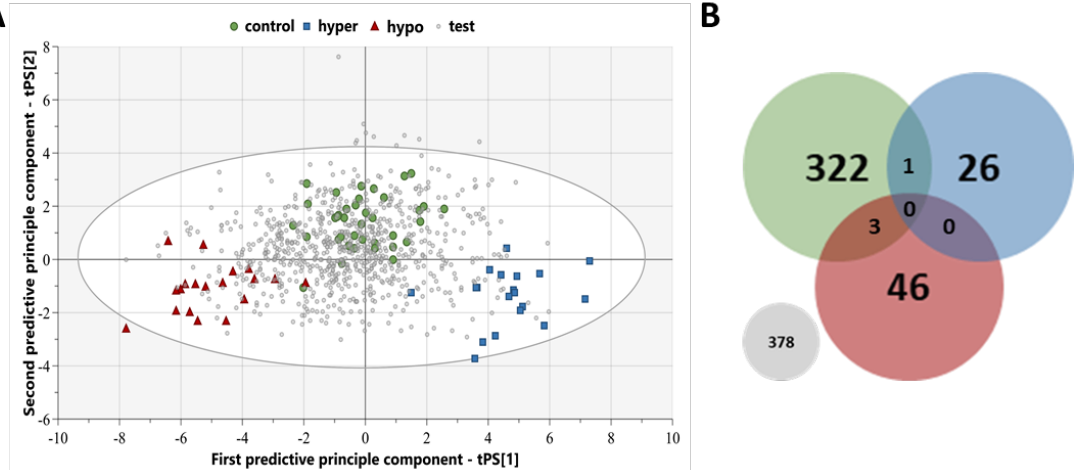
Figure 2. Screening, using a class prediction model, of the random test group of postmortem cases. ( A ) Orthogonal partial least square-discriminant analysis (OPLS-DA) score plot of the model built only including metabolic features from the shared-and-unique structures (SUS) plot that discriminant the hypo group (red triangles) from the hyper (blue squares) and control (green circles) groups. The random test cases (grey diamonds) were then screened using this class prediction model, built using the 85 metabolic feature discriminating insulin intoxications, and assigned group membership once the probability threshold of 0.65 was surpassed. ( B ) Venn diagram of the classification model with the number of test cases predicted to belong to each group: hypo (red), hyper (blue), control (green), and no group (grey). Table 4. Reported causes of death for the test group cases that were screened as possible hypoglycemia-related deaths, using a class prediction model based on the insulin intoxication metabolic